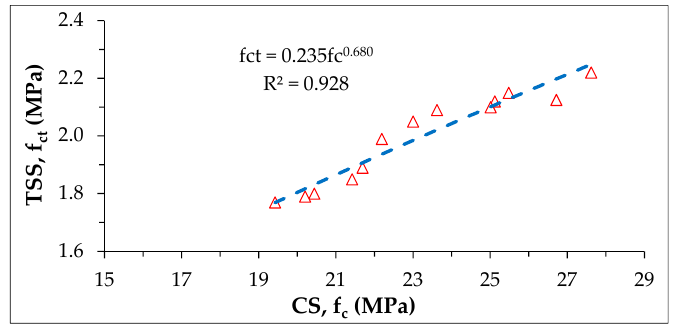
Figure 13. Tensile splitting strength for RHA and RAP inclusive concrete.